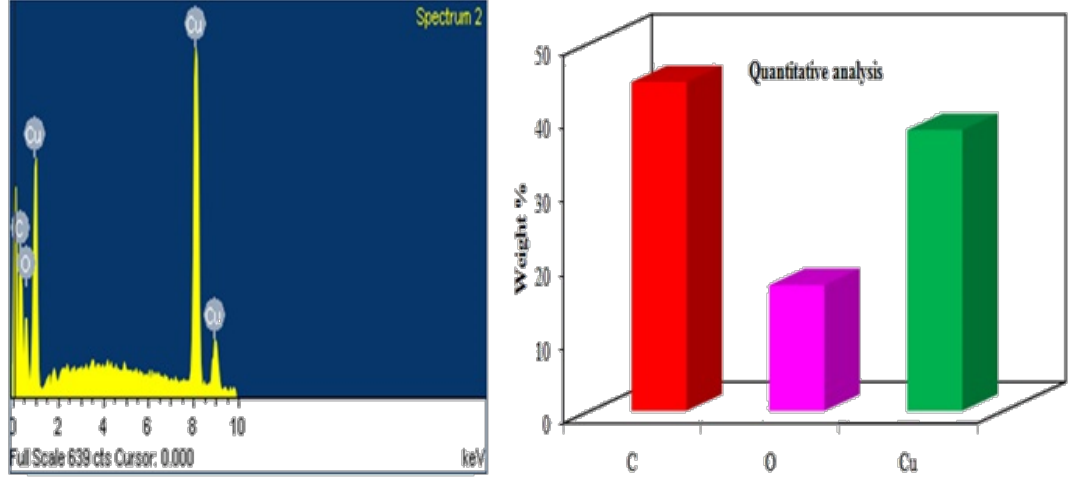
Figure 7. EDX spectrum of GCC 2.